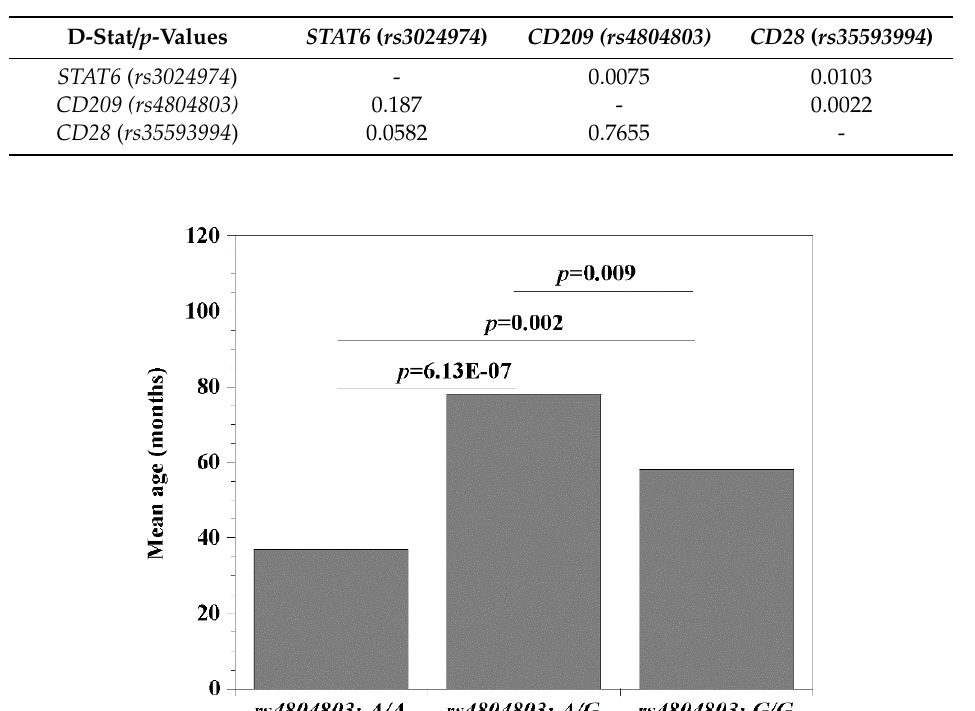
Figure 1. Mean age among malaria patients with CD209 ( snp : -383A > G; rs4804803 ) wild type, heterozygous and mutant variants. Odds ratios were calculated by Fisher’s two-tailed exact tests. A p -value < 0.05 was considered significant.